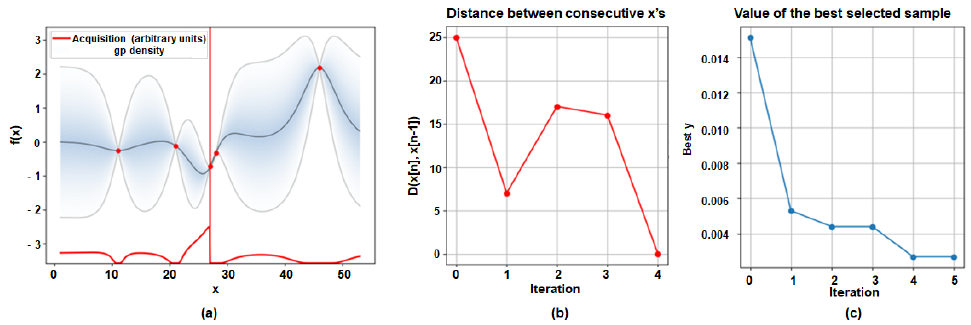
Figure 3. Visualization results of the optimal sharing layer configuration through BayesOpt using ‘PI’ as the acquisition function. (70 classes/30 classes) ( a ) the result of the selected optimal number of sharing layers. ( b ) The L2 distance of the consecutive observed points. ( c ) The value of the calculated best-selected sample for every